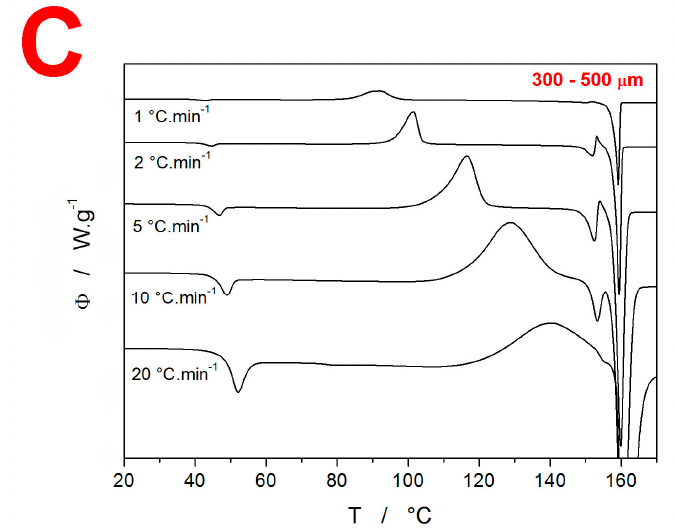
Figure 1. ( A ) Glass-forming classification experiment performed using DSC for amorphous IMC. Exothermic signals evolve in the upwards direction. ( B ) Partial crystallinity acceleration test per- formed for amorphous IMC. ( C ) Example of the series of kinetic measurements performed as simple DSC heating scans of the amorphous IMC powder at different q + .